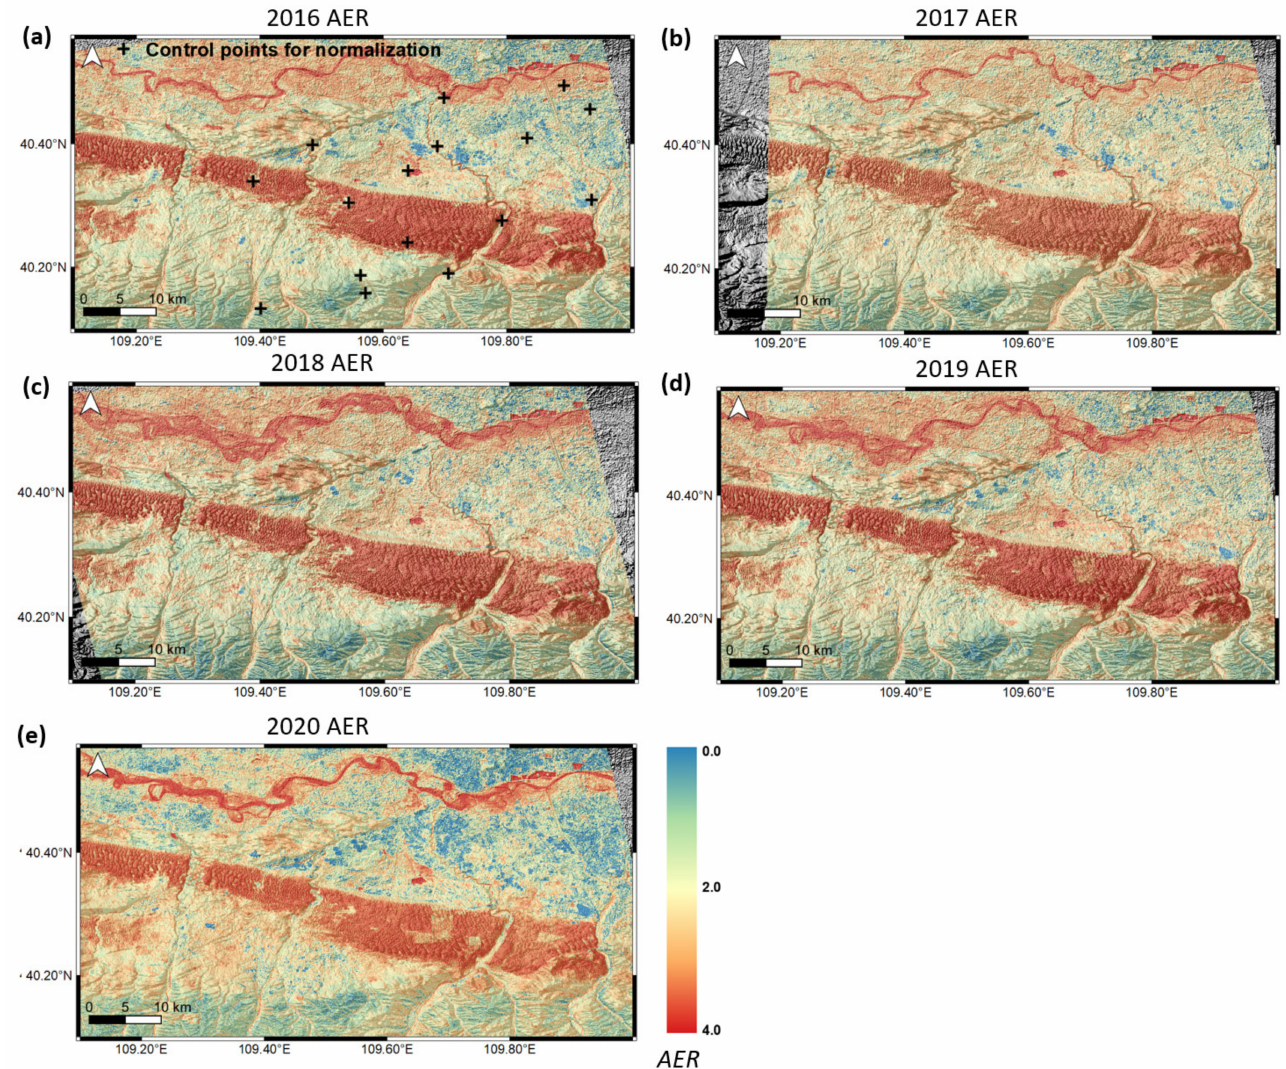
Figure 8. ( a – e ) Surface erosion map using Sentinel-1 during the 2016–2020 period. Noted that all AER maps were constructed by a posterior processor. The crosshairs in ( a ) indicate the location of ground control points for normalization. See the next section for the detailed normalization process. AERs of data sets are not controlled by each other’s data ranges. See the next section for the detailed normalization process to assign controlled data ranges using ground control